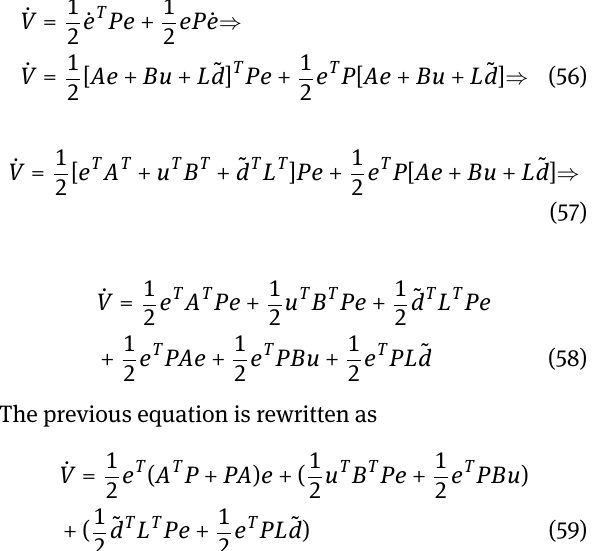
of ρ lieintheinterval[ ρ